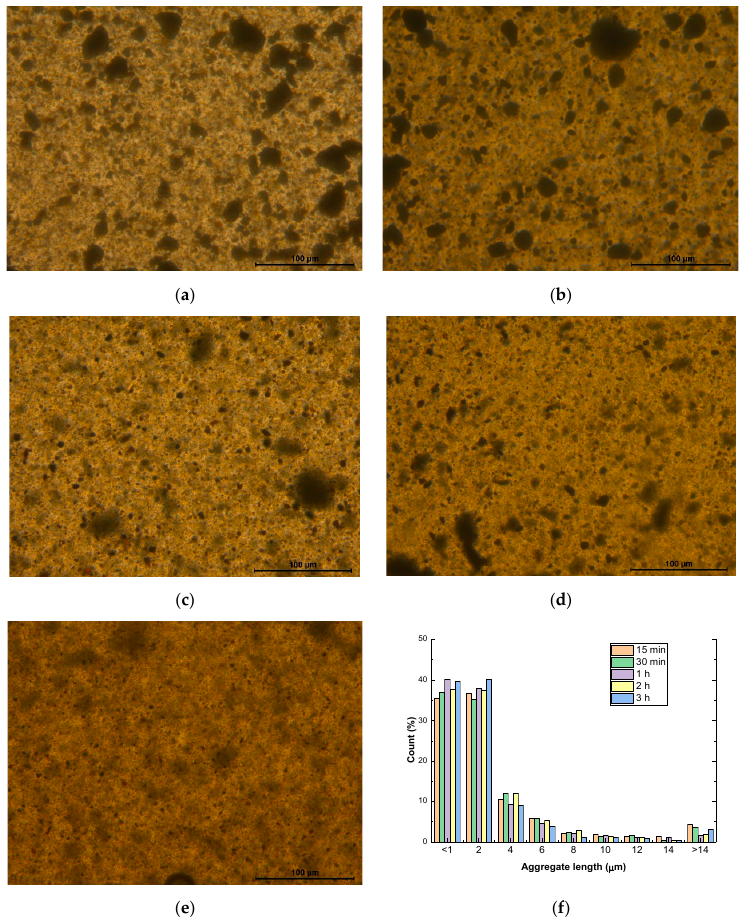
Figure 2. TOM images of the dispersion states after ( a ) 15, ( b ) 30 min, ( c ) 1, ( d ) 2, and ( e ) 3 h of sonication, and ( f ) histogram of the aggregate sizes for the different conditions.